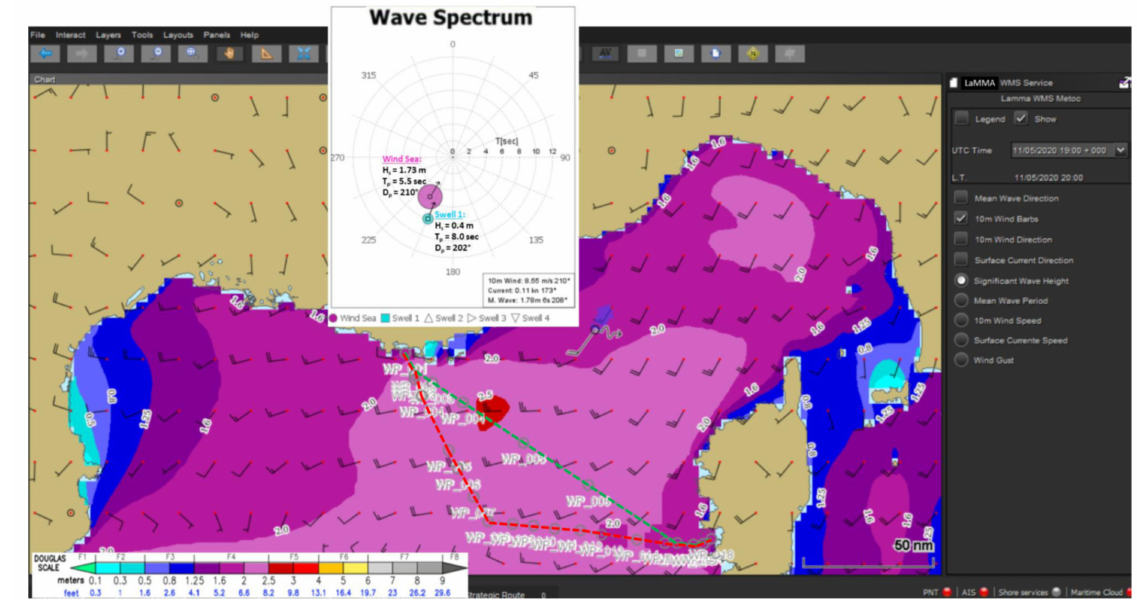
Figure 2. Loading of along-route-position time-correlated map of metocean forecast data. The SWH field is shown together with the surface Wind Barbs. Metocean data vectors are also shown in correspondence of a selected point, out of the route (same forecast time). In the “Wave Spectrum” window, the wave partitions diagram is shown (same point, same time).